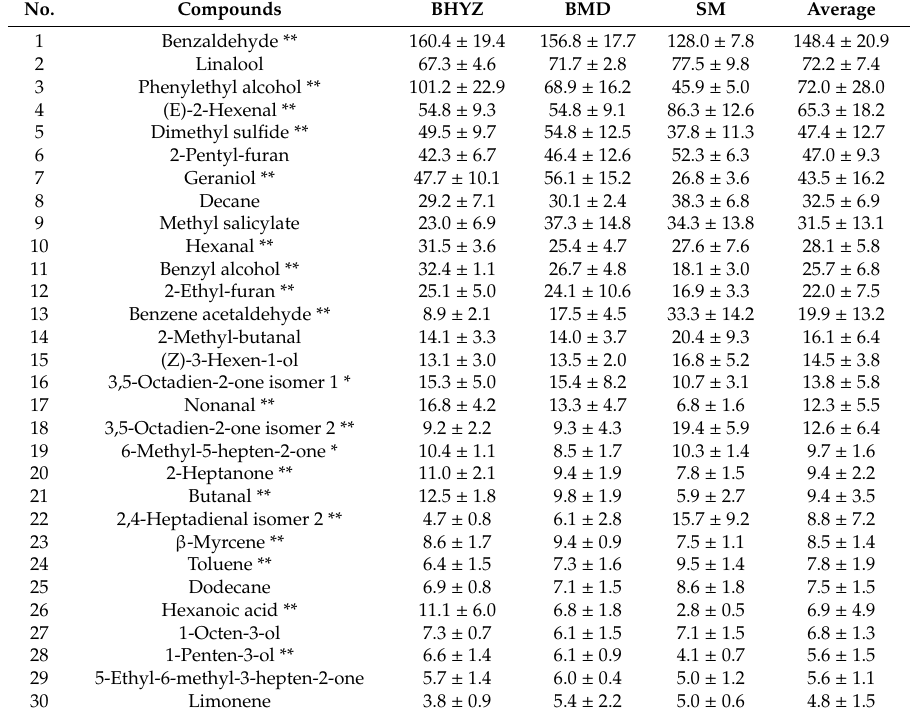
Table 1. Top 30 volatiles with high relative content (‰) in white teas detected by comprehensive two-dimensional gas chromatography–time-of-flight mass spectrometry (GC × GC–TOFMS). No.